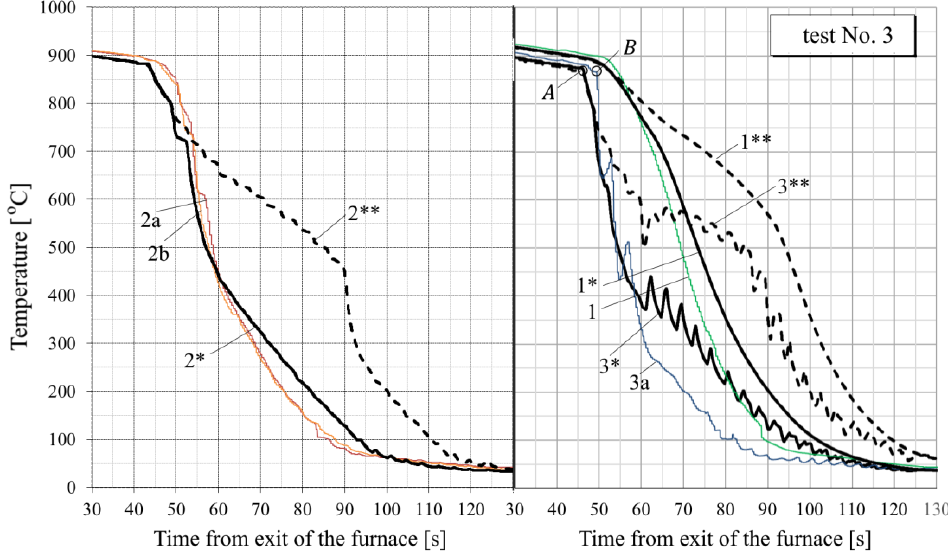
Figure 14. Graphs of cooling in test No. 3. Numbers without an asterisk denote experimental curves according to the thermocouple data: 1 — at the center of the thickness in the middle of the plate width; 2a — at the top in the middle of the width; 2b — at the top at the edge; 3a — at the bottom in the middle of the width. Numbers with one asterisk indicate calculated curves for the corresponding control points across the thickness of the plate: 1* and 1** — at the center of the sheet thickness with regard to oxide scale and without regard to oxide scale, respectively; 2* and 2** — at a depth of 3 mm from the top surface with regard to oxide scale and without regard to oxide scale, respectively; 3* and 3** — at a depth of 2.5 mm from the bottom surface with regard to oxide scale and without regard to oxide scale, respectively. Point A is the first inflection of the calculated temperature graph, corre- sponding to the beginning of water cooling from below, and point B is the same in the test (its lag for several seconds is probably due to the thermal inertia of the thermocouple).